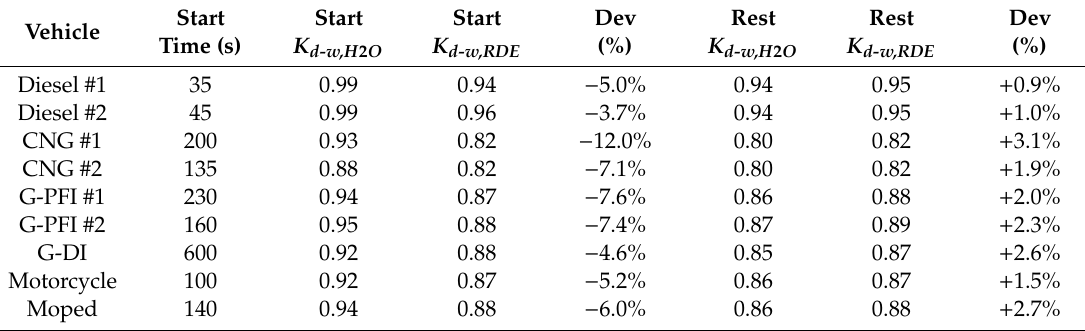
Table 3. Dry-wet conversion factors K d-w for the starting condensation period (“Start”) and the rest cycle (“Rest”) calculated before and after the “Start time” respectively. “Dev” stands for the relative deviation between the K d-w, H 2 O and the K d-w,RDE . Vehicles and acronyms as in Table